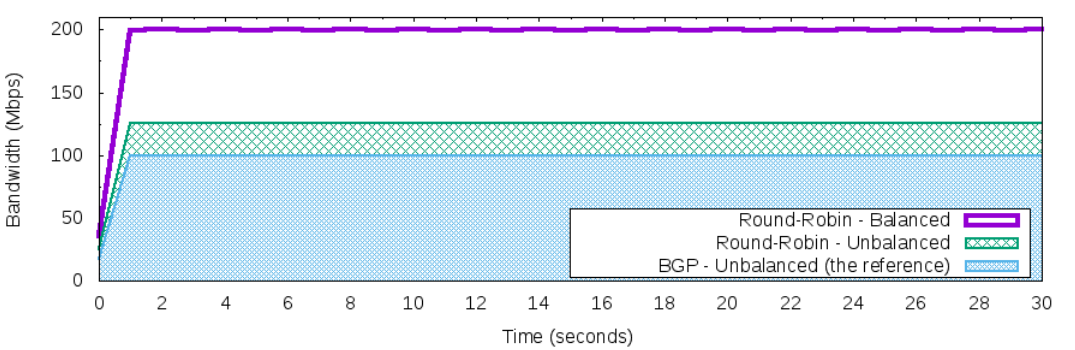
Figure 8. Round-Robin load balancer.